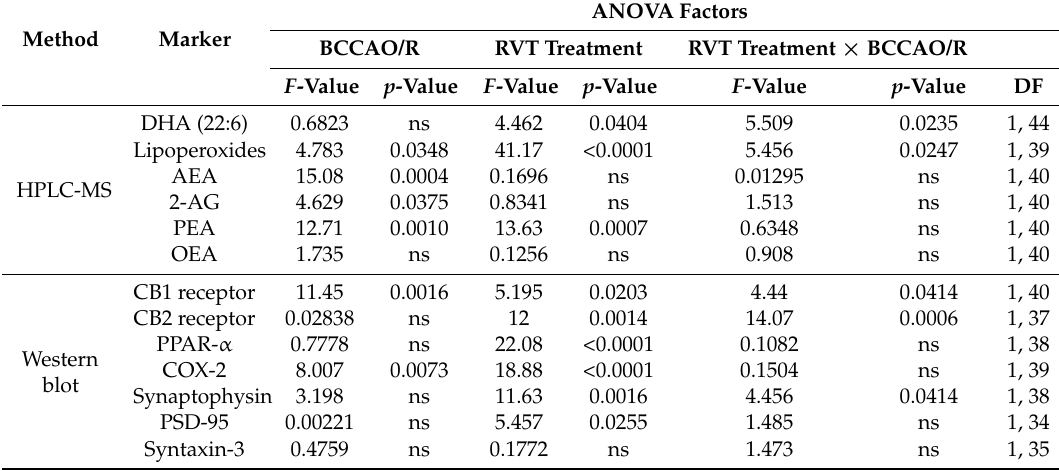
Table 2. Frontal cortex. F -values and significance levels from two-way ANOVA performed on data obtained after BCCAO/R and resveratrol (RVT) pre-treatment by means of HPLC-MS and Western